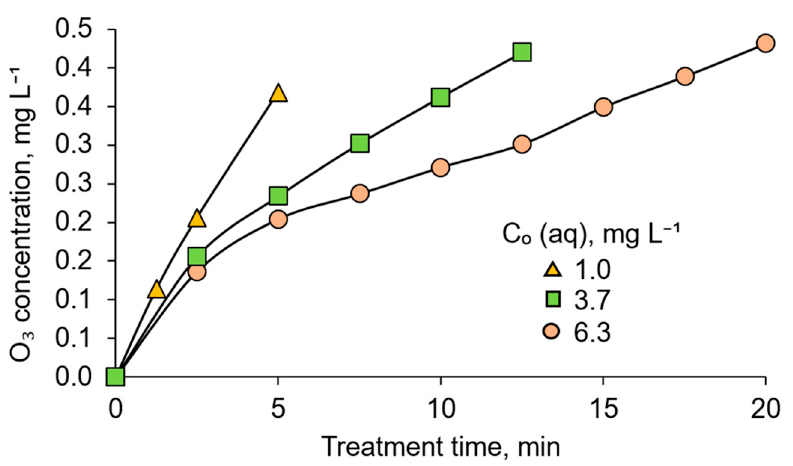
Figure 3. Gaseous ozone in PCD reactor at time of treatment dependent on the initial aqueous toluene concentration: pulse repetition frequency 200 pps, initial pH 7.0, 20 ° C.